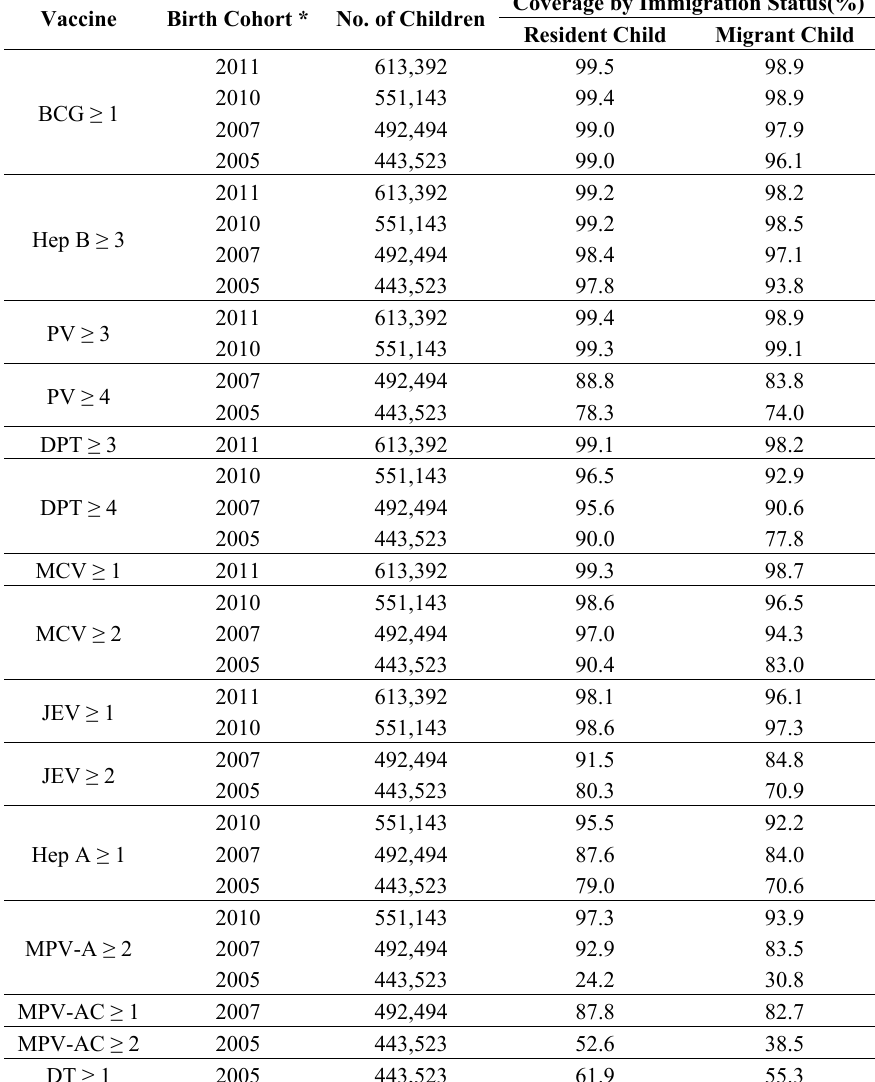
Table 6. Immunization coverage estimates by 12-month wide cohorts, vaccines and immigration status,